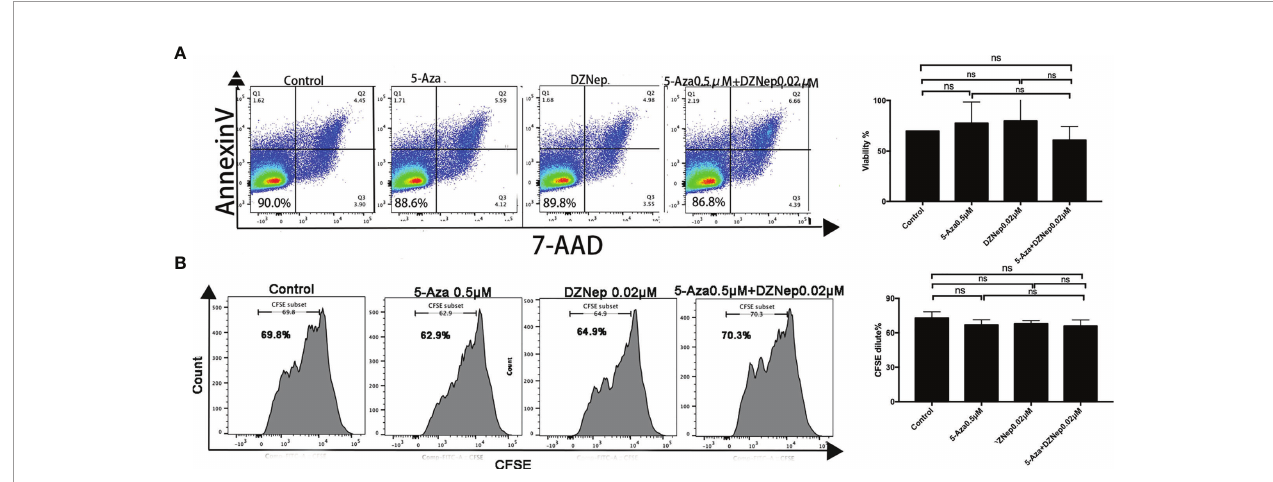
FIGURE 1 | Effects of azacitidine (5-Aza), 3-deazaneplanocin (DZNep), and related combination treatment on T-lymphocyte viability [annexin V and 7-amino actinomycin (7-AAD) double-negative cells were considered viable] (A) and proliferation [indicated by the carboxy fl uorescein diacetate succinimidyl ester (CFSE) dilution] (B) . The data shown were summarized from three independent experiments. ns: p >